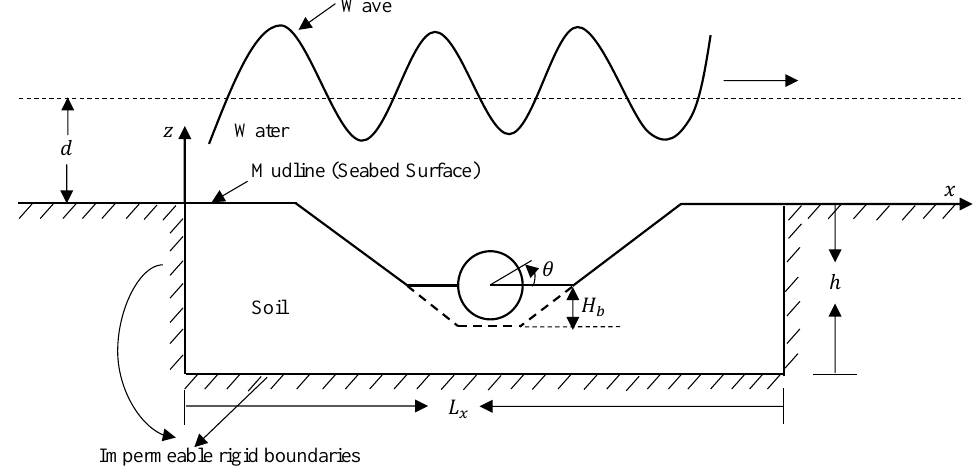
Figure 1. Sketch for wave-seabed-pipeline